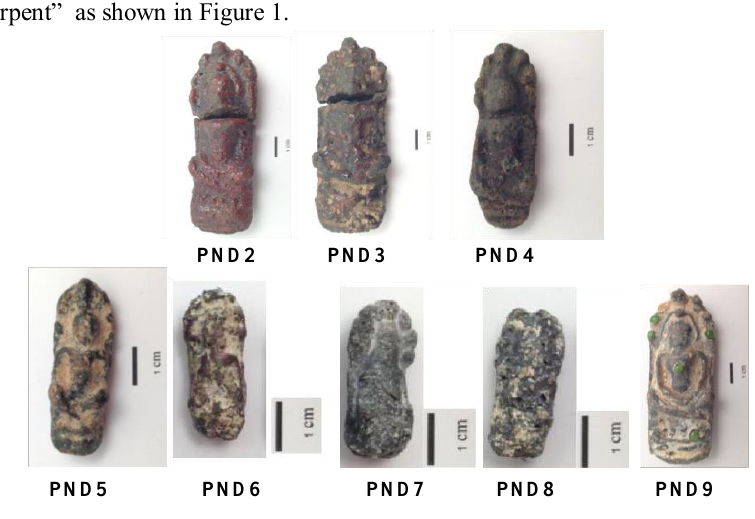
Fig. 1. Samples of Phra Kru Nadune